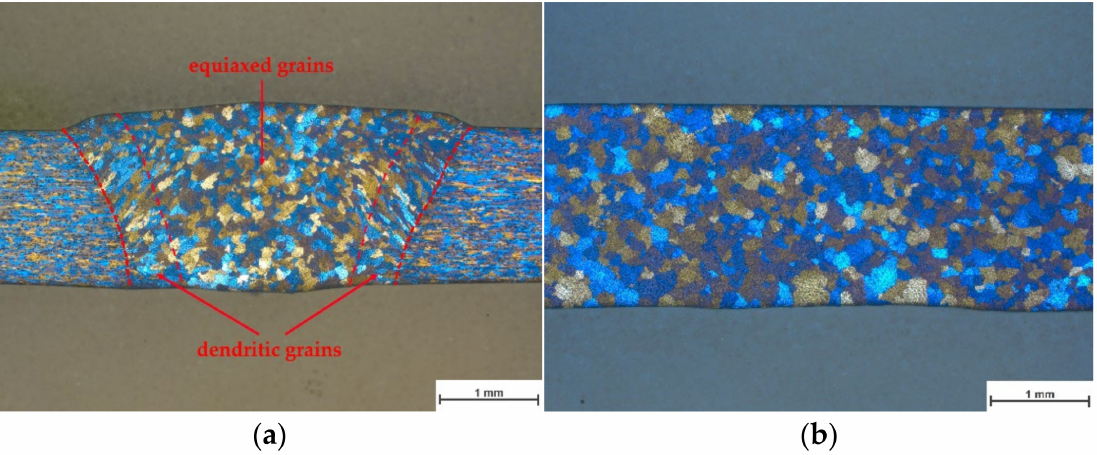
Figure 5. ( a ) cross-section of the reference figure R; ( b ) longitudinal section of the reference